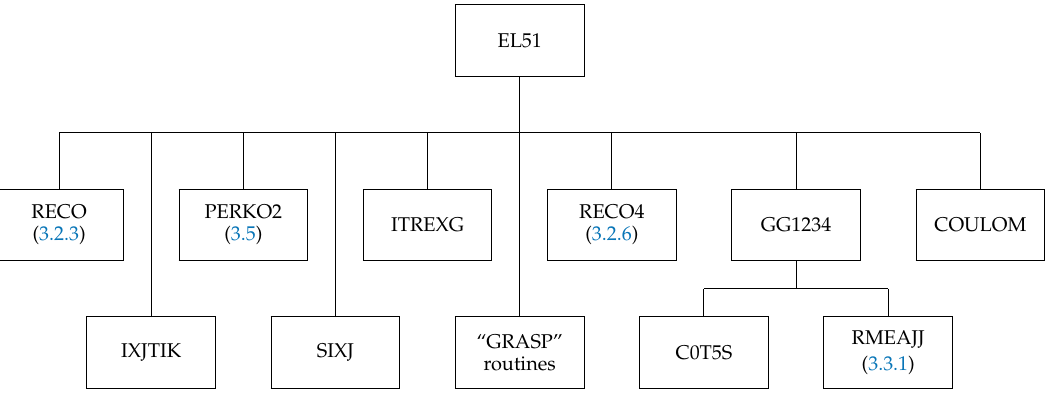
Figure 9. Structure of the subroutine EL51 . The box “GRASP” routines correspond to the routines SNRC , CXK , SPEAK , and TALK from the GRASP92 package